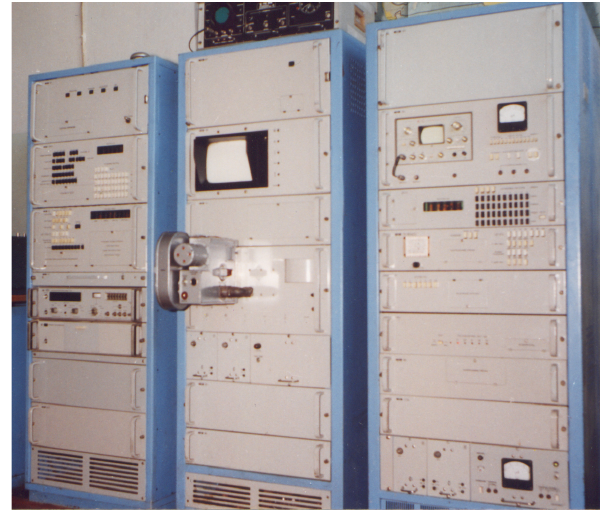
Figure 5. Ionosonde “Basis”.